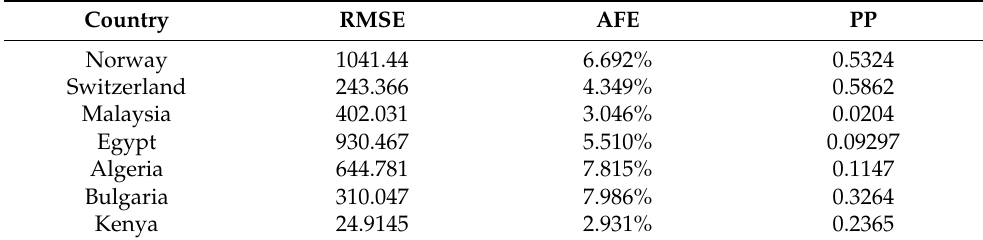
Table 1. Forecasting results for the ANN model.